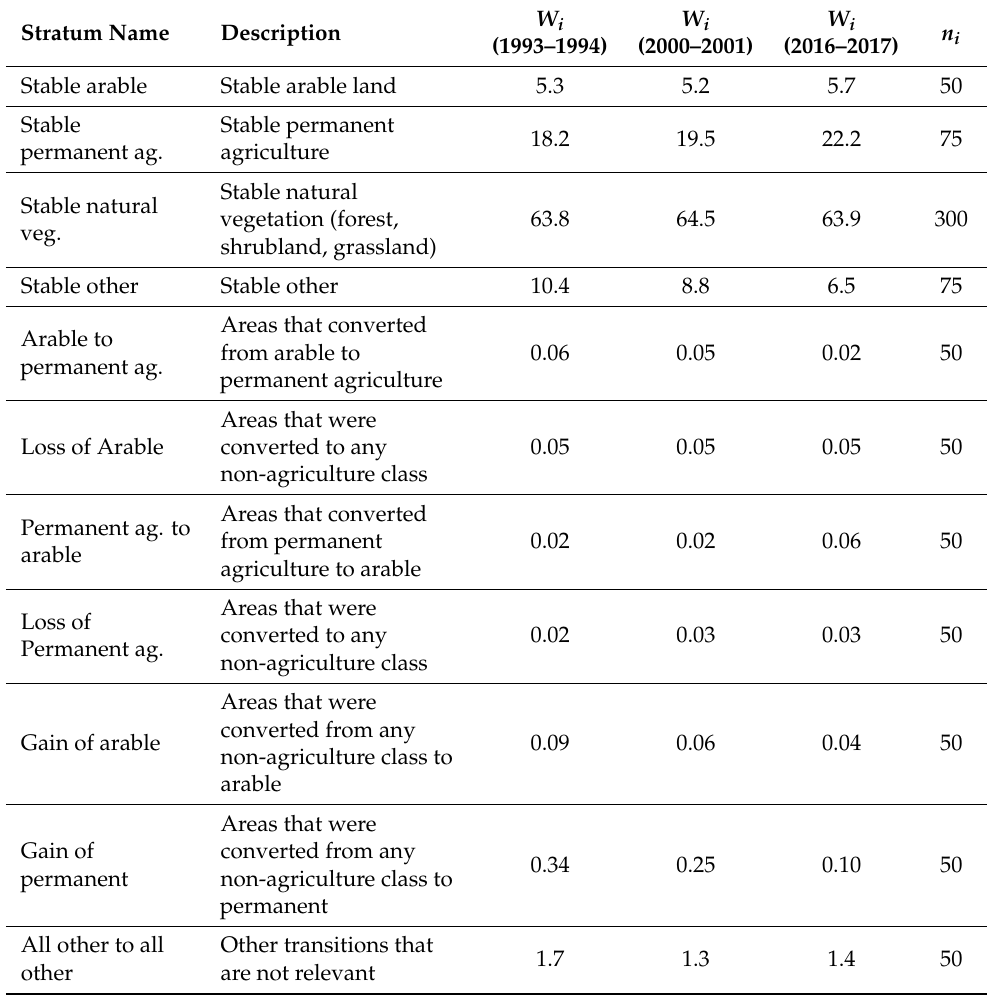
Table 4. Strata and their description, strata weight ( W i ) based on the maps of stable and change classes between 1993–1994, 2000–2001, and 2016–2017, and the number of samples per stratum ( n i